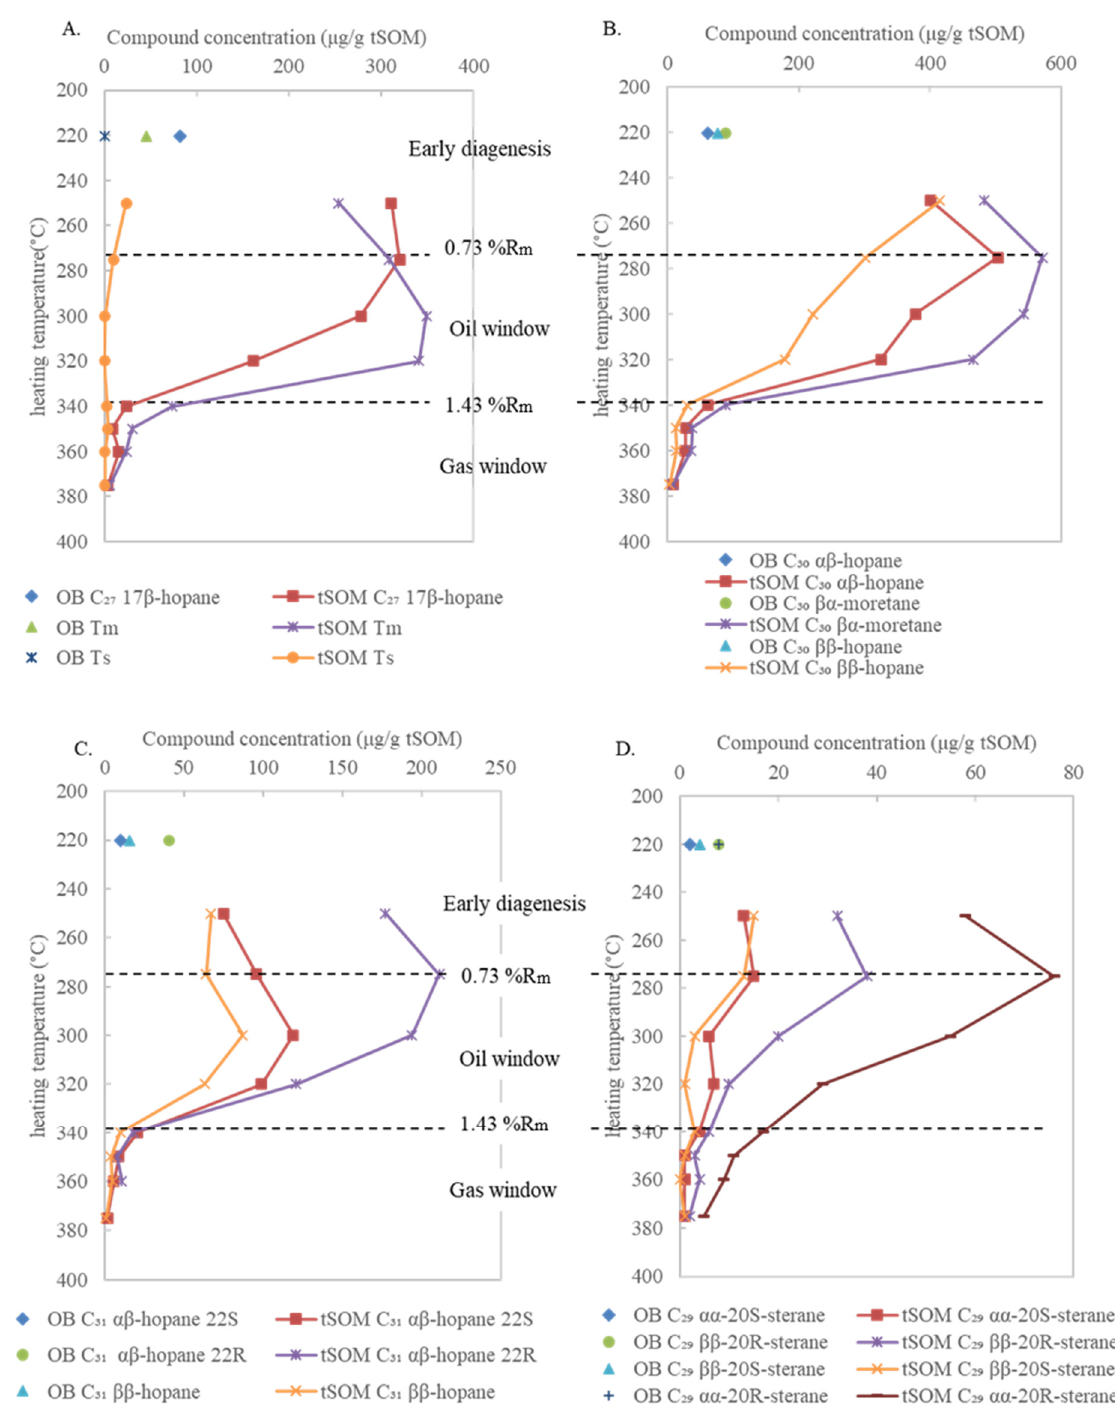
Figure 5. Variations in hopane and sterane isomer concentrations in the OB and the tSOMs (own elaboration). Each data dot on subfigure ( A – D ) represents concentration of the corresponding compound in either the original bitumen (OB) or the total soluble organic material (tSOM), e.g., OB C 27 17 β -hopane referring to the concentration of C 27 17 β -hopane in the original bitumen. The OB was assigned a heating temperature of 220 °C for visualization purpose only. See Figure 4 for peak identification.